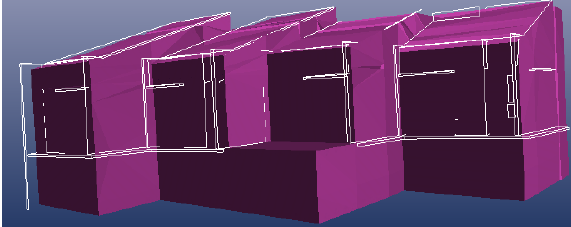
Figure 16. Photomodeler digitization results on the basis of 3D